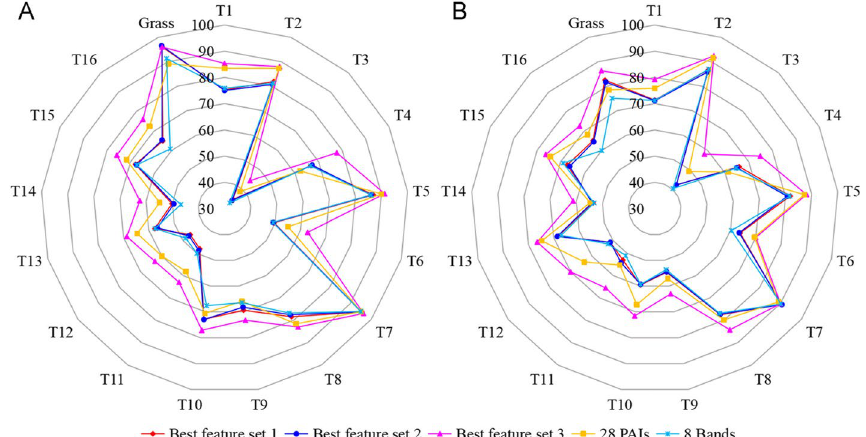
Fig. 4 Spider web graphs of the representative feature set classification results. A Spider web graph of producer accuracies. B Spider web graph of user